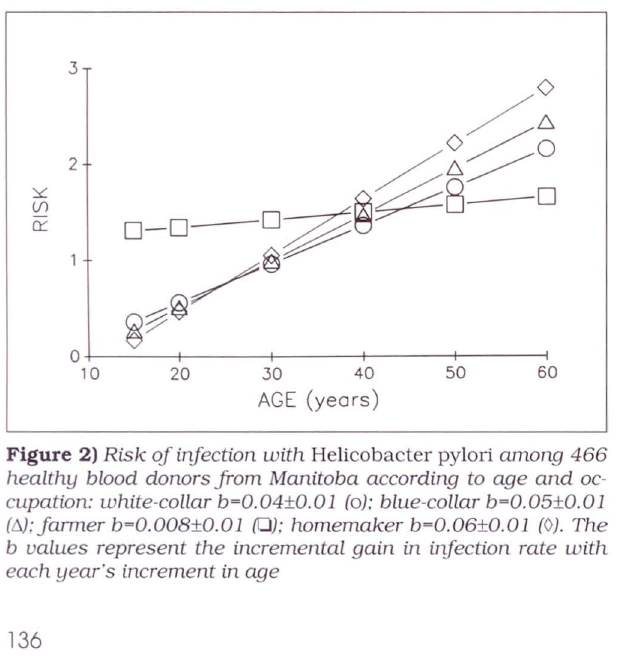
Figure 2) Risk of injection with Helicobacter pylori among 466 healthy blood donors from Manitoba according to age and oc cupation: white-collar b=0.04±0.01 (oJ; blue-collar b=0.05±0.01 (t,.J; farmer b=0.008±0.01 (OJ; homemaker b=0.06±0.01 (OJ. The b values represent the incremental gain in injection rate with each year·s increment in age